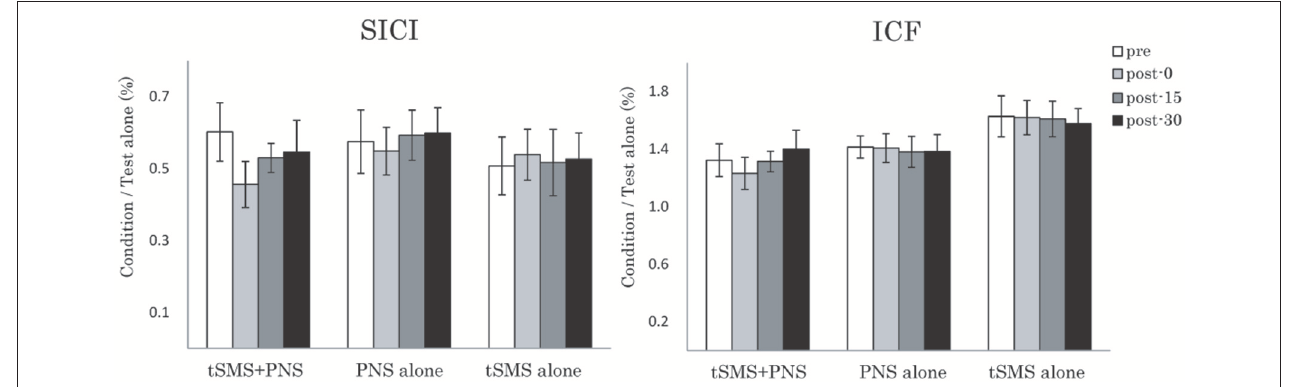
FIGURE 4 | Effects of combining tSMS with PNS on the SICI and ICF in the right APB muscle. There were no significant changes of right APB. Error bars are standard errors of the